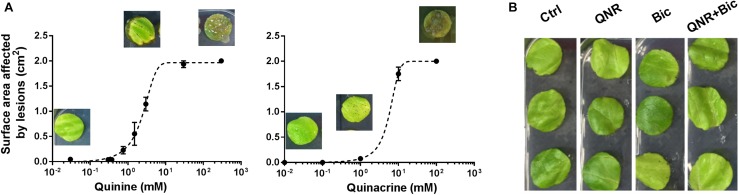
Quinine and quinacrine show little toxicity in planta. Agents were sprayed onto lettuce leaves which were examined after 3 days for lesions arising from quinine or quinacrine individually (A), and quinacrine in combination with bicarbonate (B). The images in panel (A) correspond to the relevant, indicated drug concentrations. Total surface area of the leaf disks was 2 cm2. The values are means ± SEM from eight leaves. Ctrl, control; QNR, 100 μM quinacrine; Bic, 20 mM bicarbonate.